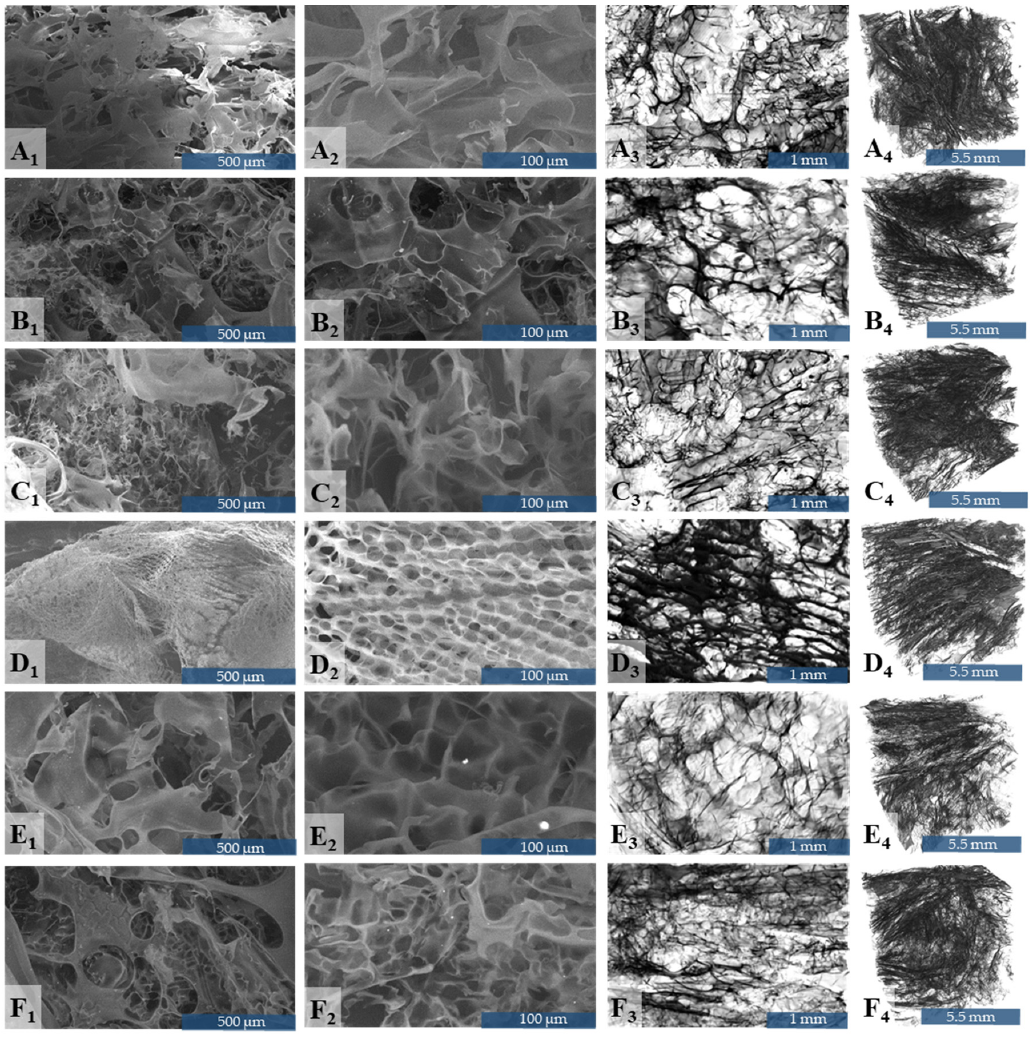
Figure 3. Morphological characterization of GCs ( A ), GCsGp ( B ), GCsGp/GO 0.5% ( C ), GCsGp/GO 1% ( D ) GCsGp/GO 2% ( E ), and GCsGp/GO 3% ( F ) through SEM (1–2) and µCT (3–4).